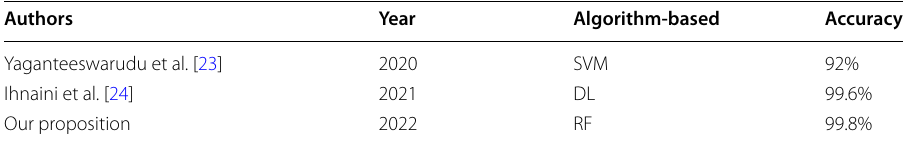
Table 6 Summary of the different algorithms on Dataset3